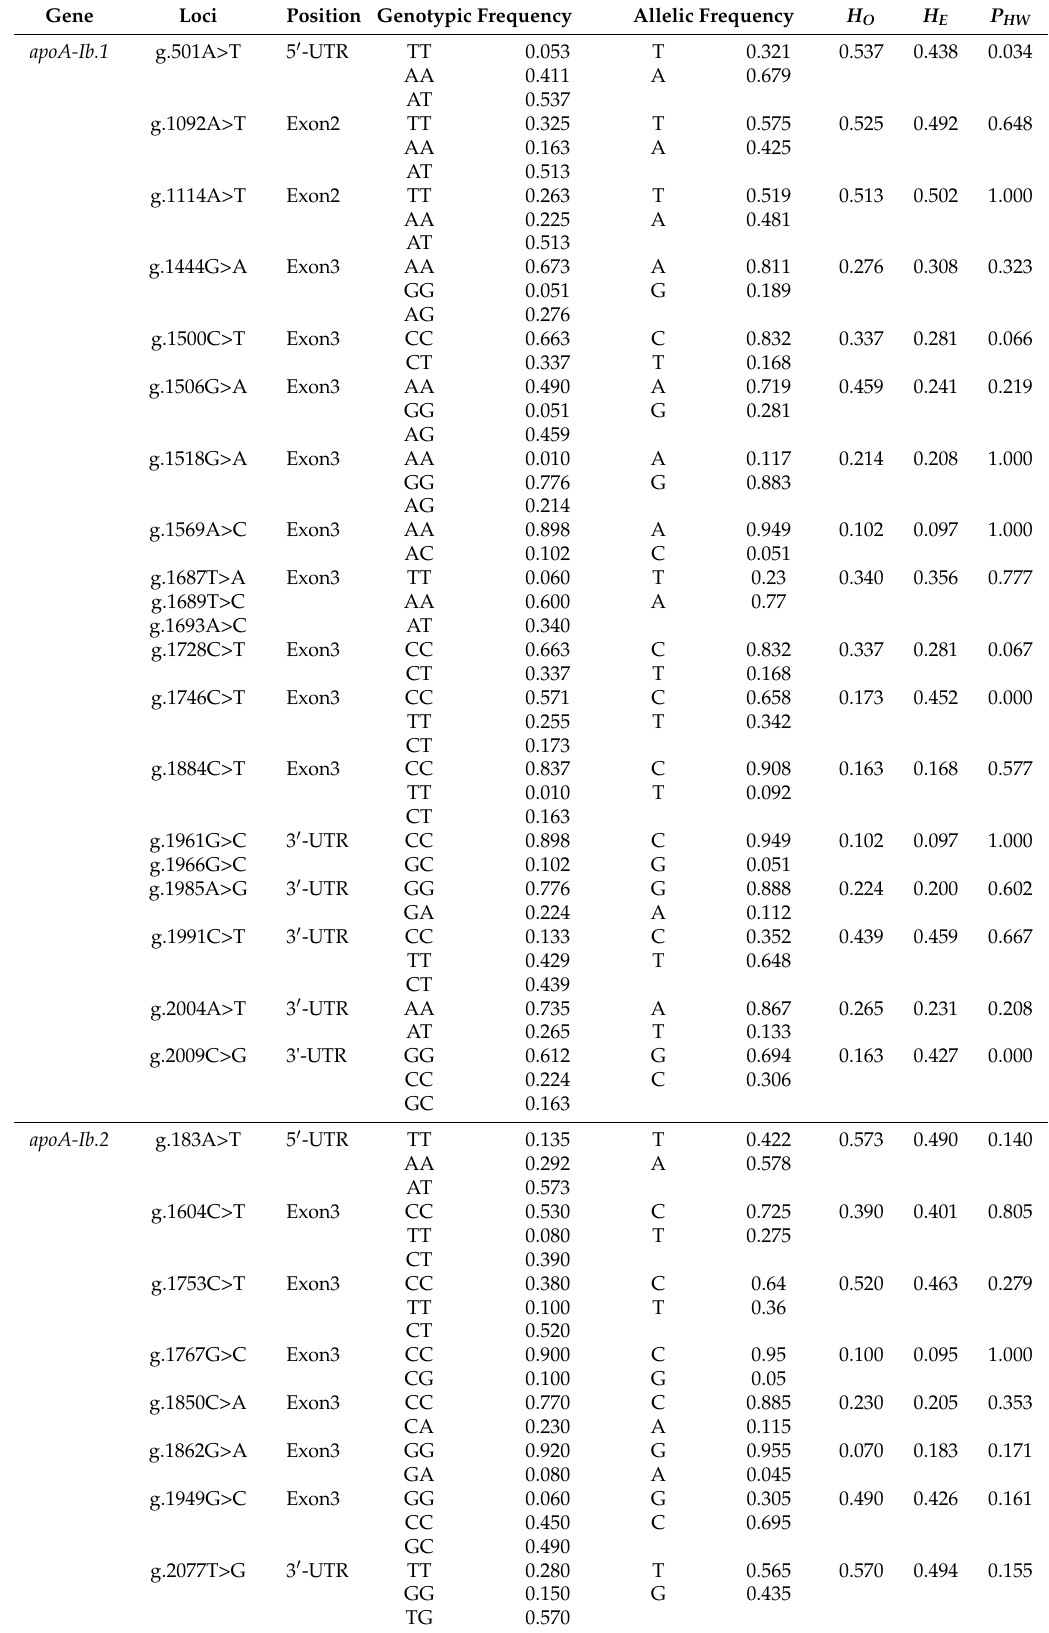
Table 1. Genetic diversity based on single-nucleotide polymorphisms of a poA-Ibs in the test population of Yellow River